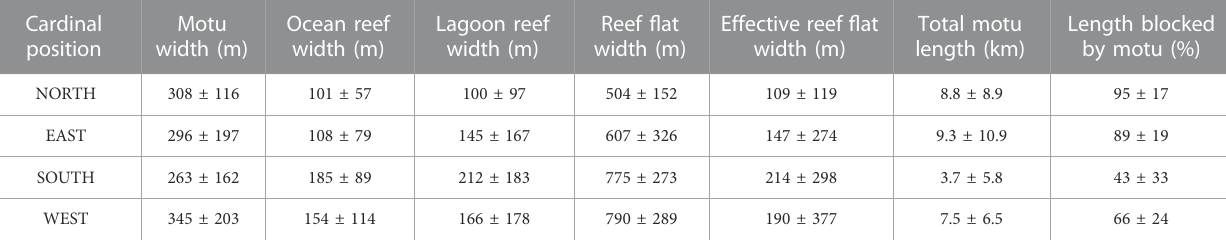
TABLE 1 Median with one standard deviation per atoll cardinal position binned for French Polynesia motu and reef- fl at morphometrics. Cardinal Motu Ocean reef Lagoon reef Reef fl at position width (m) width (m) width (m) width